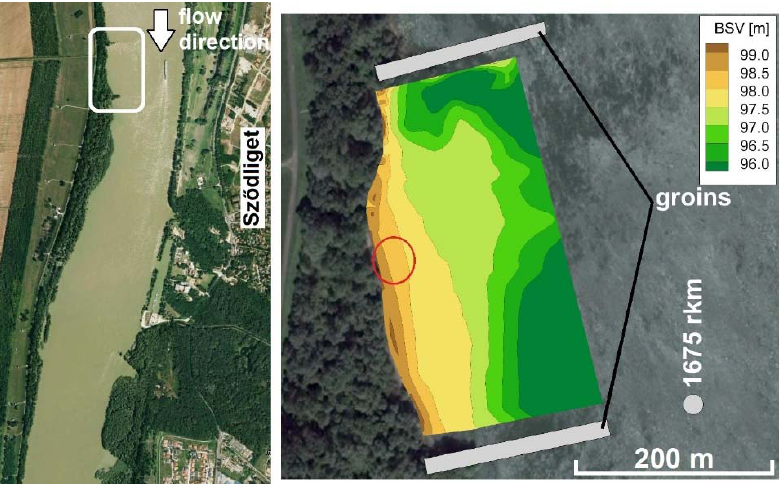
Figure 1. Ortophoto of the study site, marked with the white circle in the magnified right view. Bed elevation (meters above Baltic Sea) contour map is triangulated based on acoustic depth and GPS measurements. The mean water level during the measurements was 99.95 m.